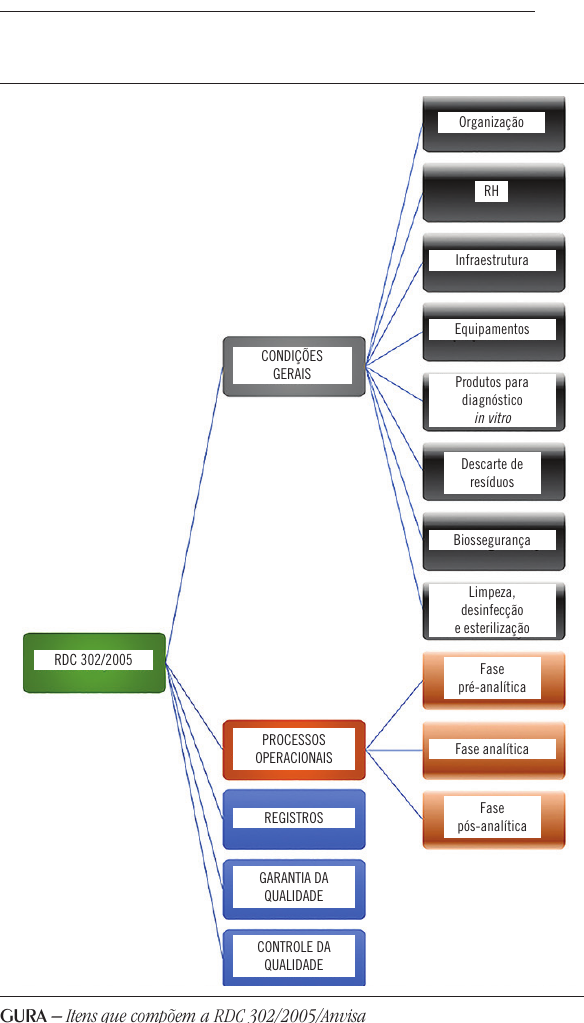
Figura – Itens que compõem a RDC